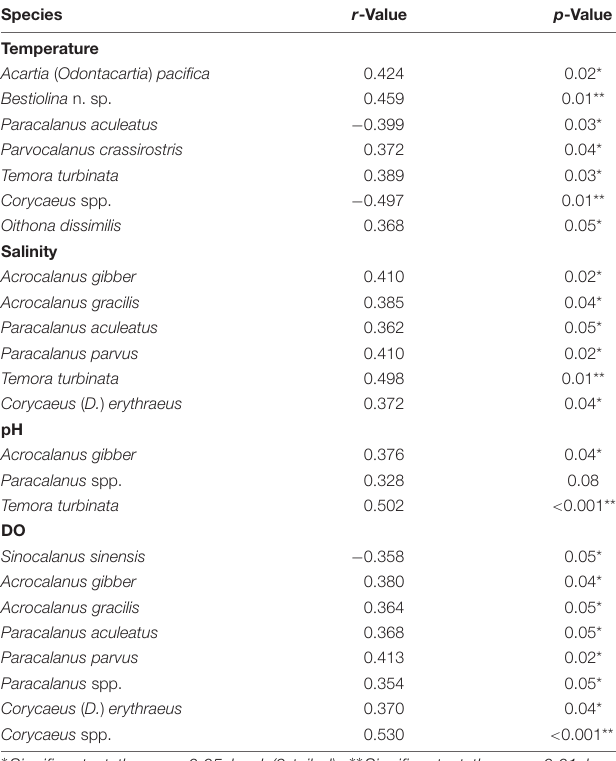
TABLE 4 | Significant correlations between the density of copepod species and temperature, salinity, pH, and dissolved oxygen concentration (DO), as determined by Pearson’s correlation